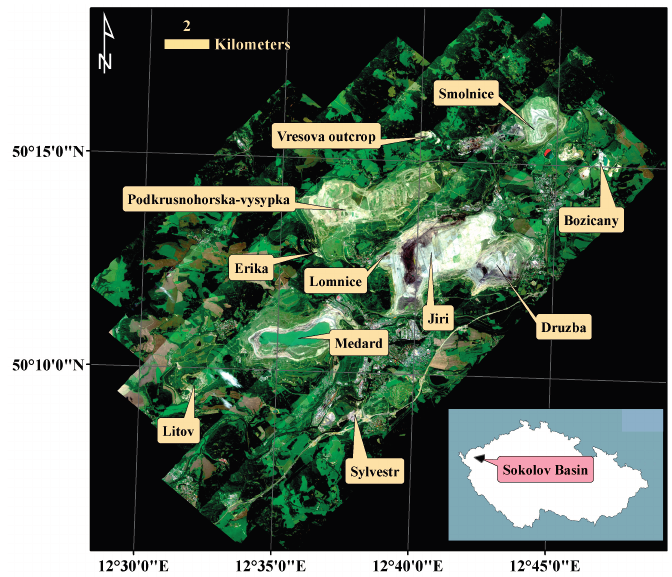
Figure 1. Image of the Sokolov lignite mining area acquired with the HyMap airborne sensor during a campaign over this area in August